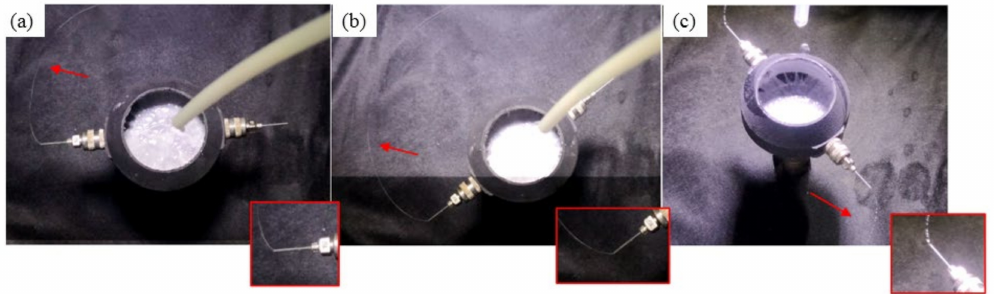
Figure 12. The state change of the centrifugal jet of PEO solution with different mass fractions: ( a ) 7.5%; ( b ) 6.5; ( c ) 4.5.